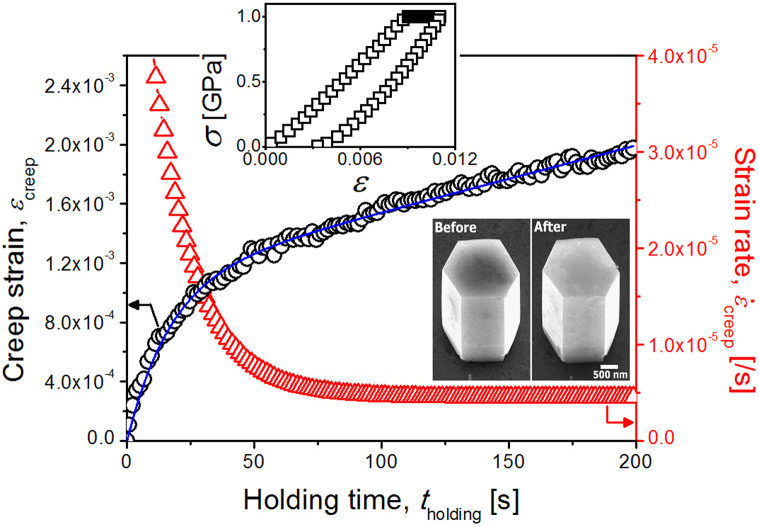
Typical example of εcreep (and ) vs. tholding curves.Inset shows the representavie σ-ε curve and the SEM images of a nanorod taken before and after creep tests.